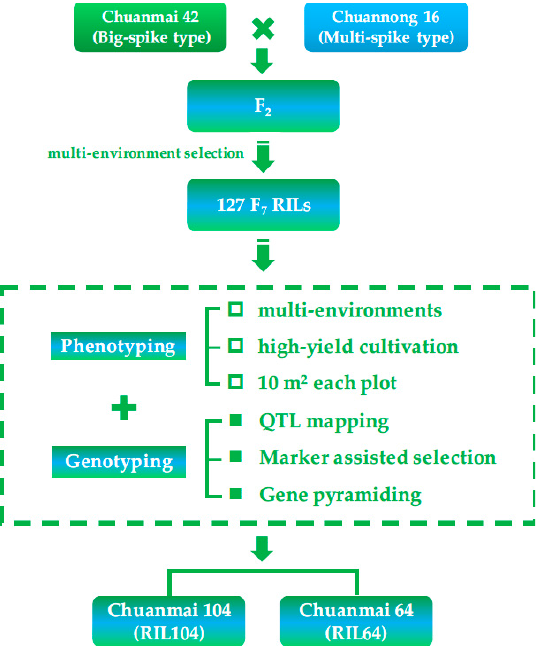
Figure 5. Application of SHW derivatives and breeding procedure of Chuanmai 104.